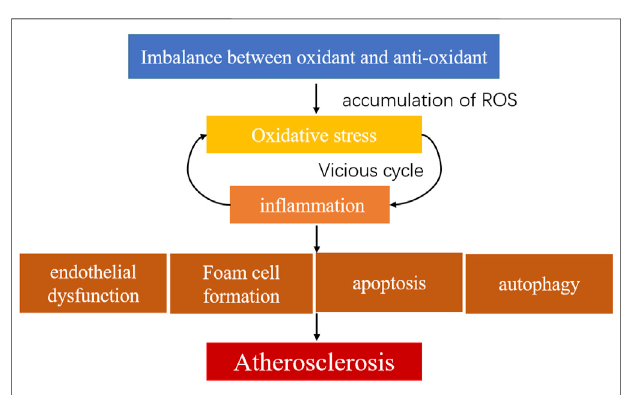
FIGURE 2 | Oxidative stress in